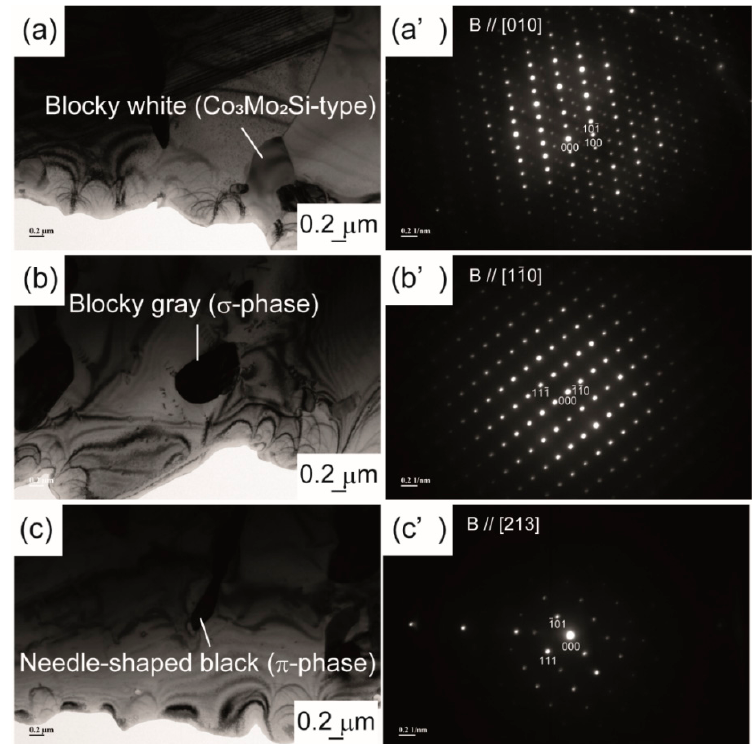
Figure 8. Transmission electron microscopy-bright field (TEM-BF) images and selected area diffraction patterns (SADPs) of the ( a , a’ ) blocky white, ( b , b’ ) blocky gray, and ( c , c’ ) needle-shaped black precipitates of the low-C as-built alloy.